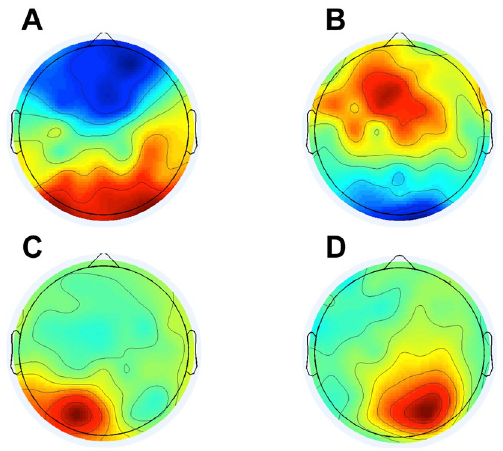
Figure 6. Regions of interest (ROIs). Templates of relevant components for frontal ( A , B ), left parieto-occipital ( C ) and right parieto-occipital ( D )